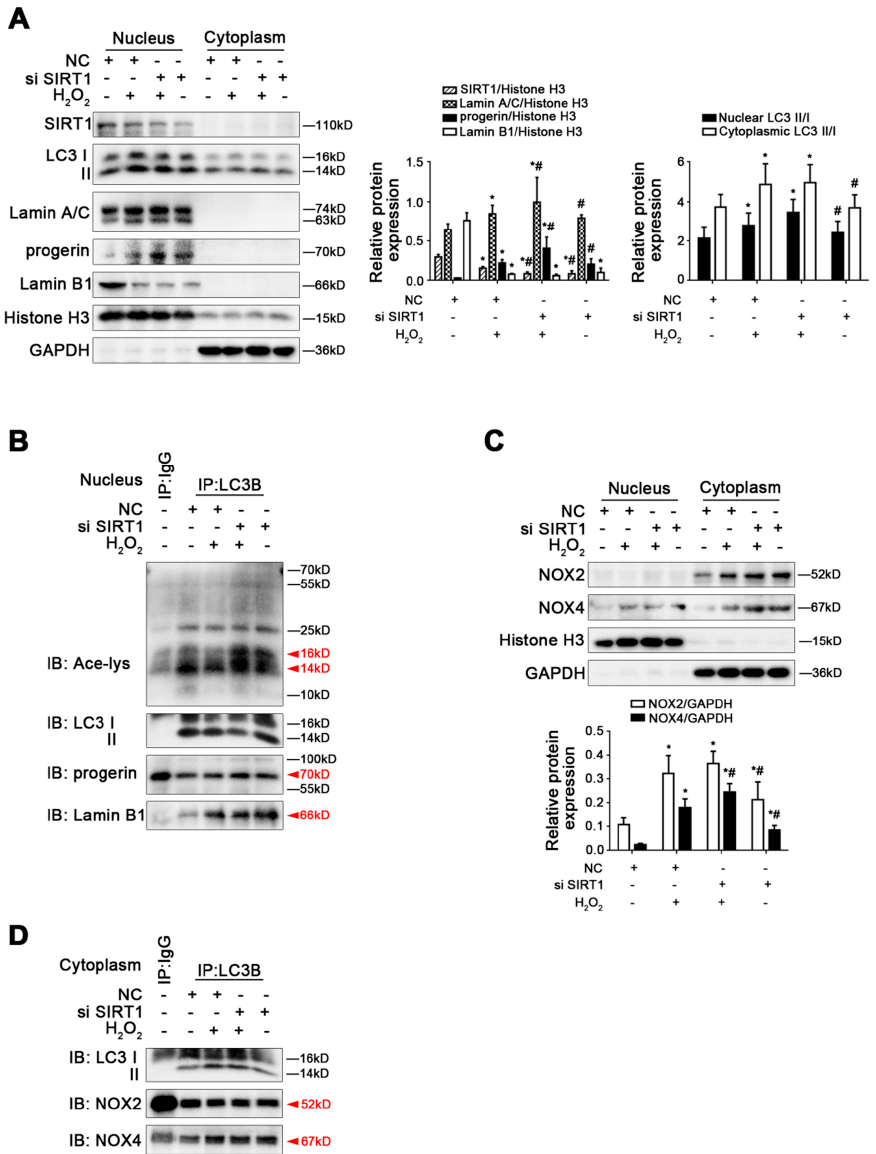
Figure 8. Knockdown of SIRT1 with siRNA activated Lamin B1 nucleophagic degradation but did not change H 2 O 2 -induced elevated progerin. Rat primary LSECs were transfected with SIRT1 siRNA or nontarget siRNA (called NC) and then treated with H 2 O 2 (10 μ M) for 48 h. The transfection efficiency was about 75%. ( A ) Representative immunoblots of SIRT1, LC3 II/I, Lamin A/C, progerin, and Lamin B1 in nucleus and cytoplasm of primary LSECs in the four groups (NC, NC+H 2 O 2 , si SIRT1+H 2 O 2 , si SIRT1). The relative protein expression and LC3 II/I expression in nucleus and cytoplasm are quantified in the two graphs (right). * p < 0.05 versus the NC group; # p < 0.05 versus the NC+H 2 O 2 group. ( B ) The interaction of nuclear LC3B with acetyl Lysine, progerin, and Lamin B1 was detected by the co-IP assay. Nuclear LC3B in primary LSECs was individually immunoprecipitated, and subsequently, acetyl Lysine, progerin, Lamin B1, and LC3 II/I in nucleus of LSECs in the four groups were subjected to immunoblotting analysis. ( C ) Representative immunoblots of NOX2 and NOX4 in nucleus and cytoplasm of primary LSECs in the four groups. The relative protein expression is quantified in the graph (below). * p < 0.05 versus the NC group; # p < 0.05 versus the NC+H 2 O 2 group. ( D ) The interaction of cytoplasmic LC3B with NOX2 and NOX4 was detected by the co-IP assay. Cytoplasmic LC3B in primary LSECs was individually immunoprecipitated, and subsequently, NOX2, NOX4, and LC3 II/I in cytoplasm of LSECs in the four groups were subjected to immunoblotting